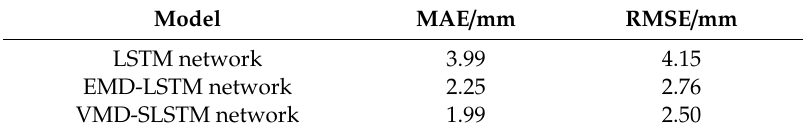
Table 1. Forecast errors of landslide displacement using three forecasting